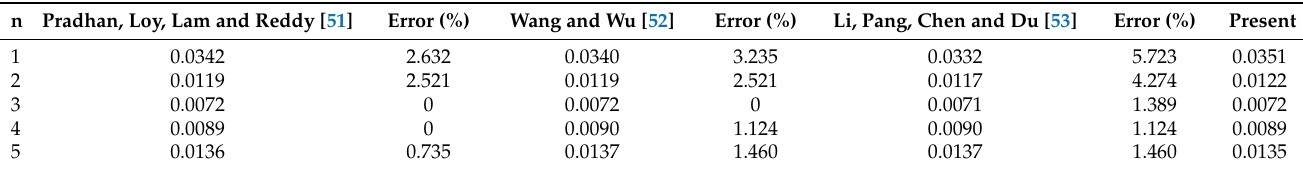
Table 2. Comparison of non-dimensional natural frequencies ( ω = R ω boundary condition.